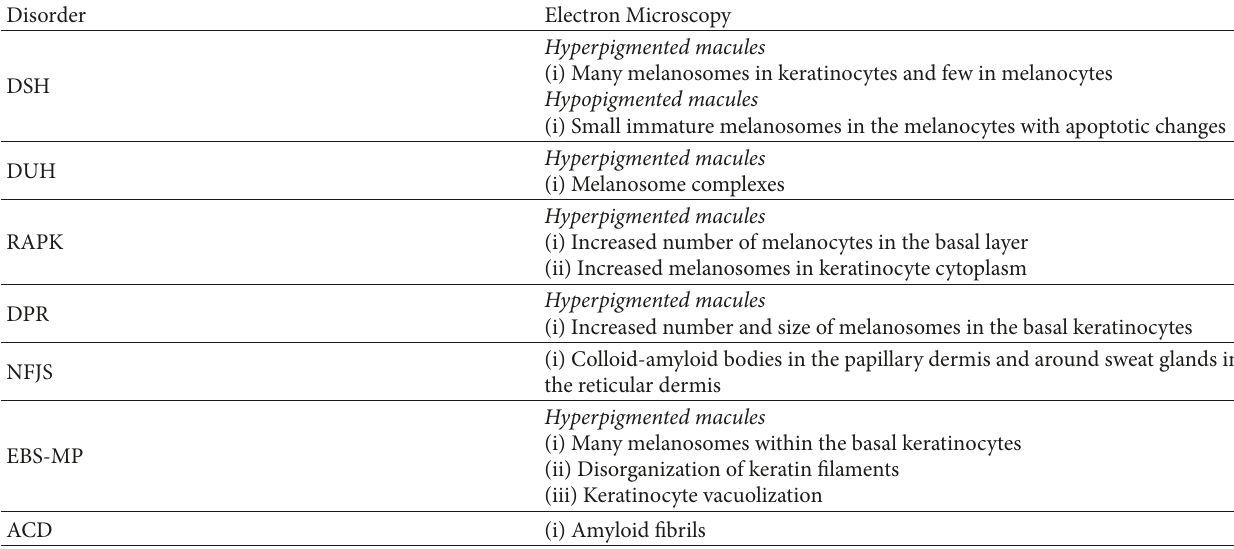
Table 4: Histopathological features, electron